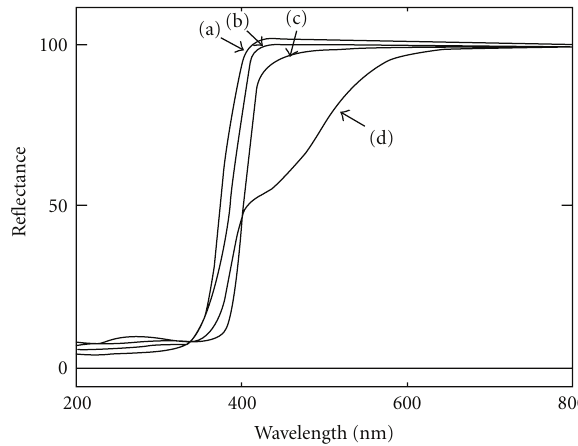
Figure 3: UV-vis reflectance spectra of (a) TiO 2 , (b) P-25, (c) undoped hollow TiO 2 sphere, and (d) N-doped hollow TiO 2 sphere